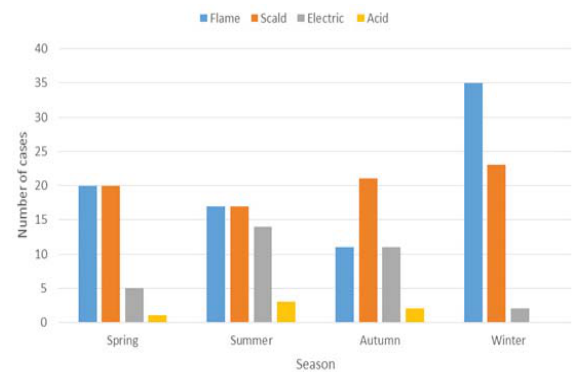
Figure 7. Patient distribution according to cause of